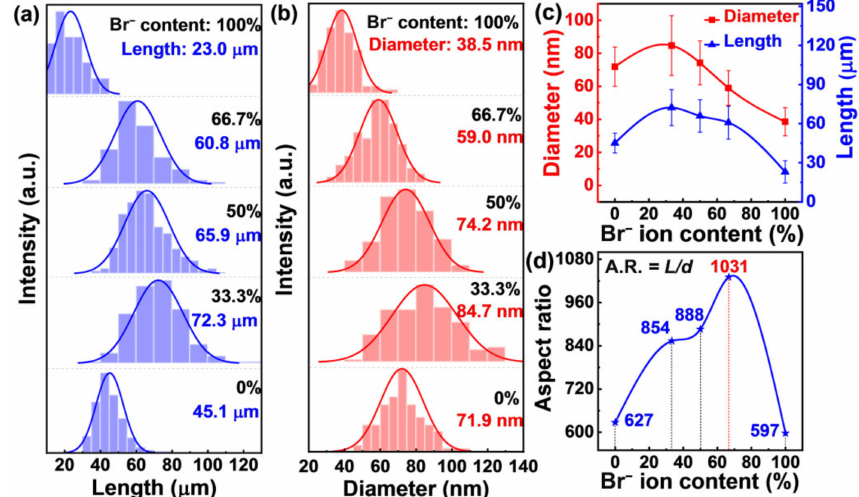
Figure 2. The histograms of length ( a ) and diameter ( b ) of AgNWs with Br − ion content varied from 0% to 100% in total halogens. Changes in AgNWs diameter and length with Br − ion content are summarized in ( c ). The aspect ratios of AgNWs with Br − ion content are summarized in ( d